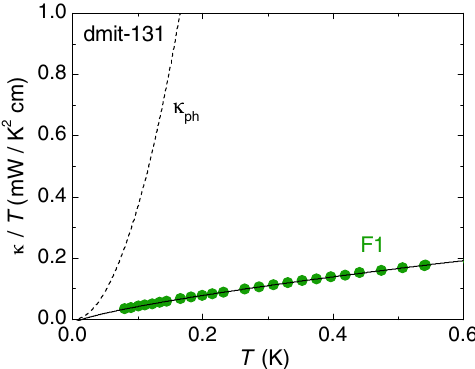
FIG. 6. The same data (green dots) and fit (full line) as in Fig. 2, for sample F1. For comparison, the dashed line is the phonon thermal conductivity expected for that sample if phonons were only scattered by the sample boundaries (see